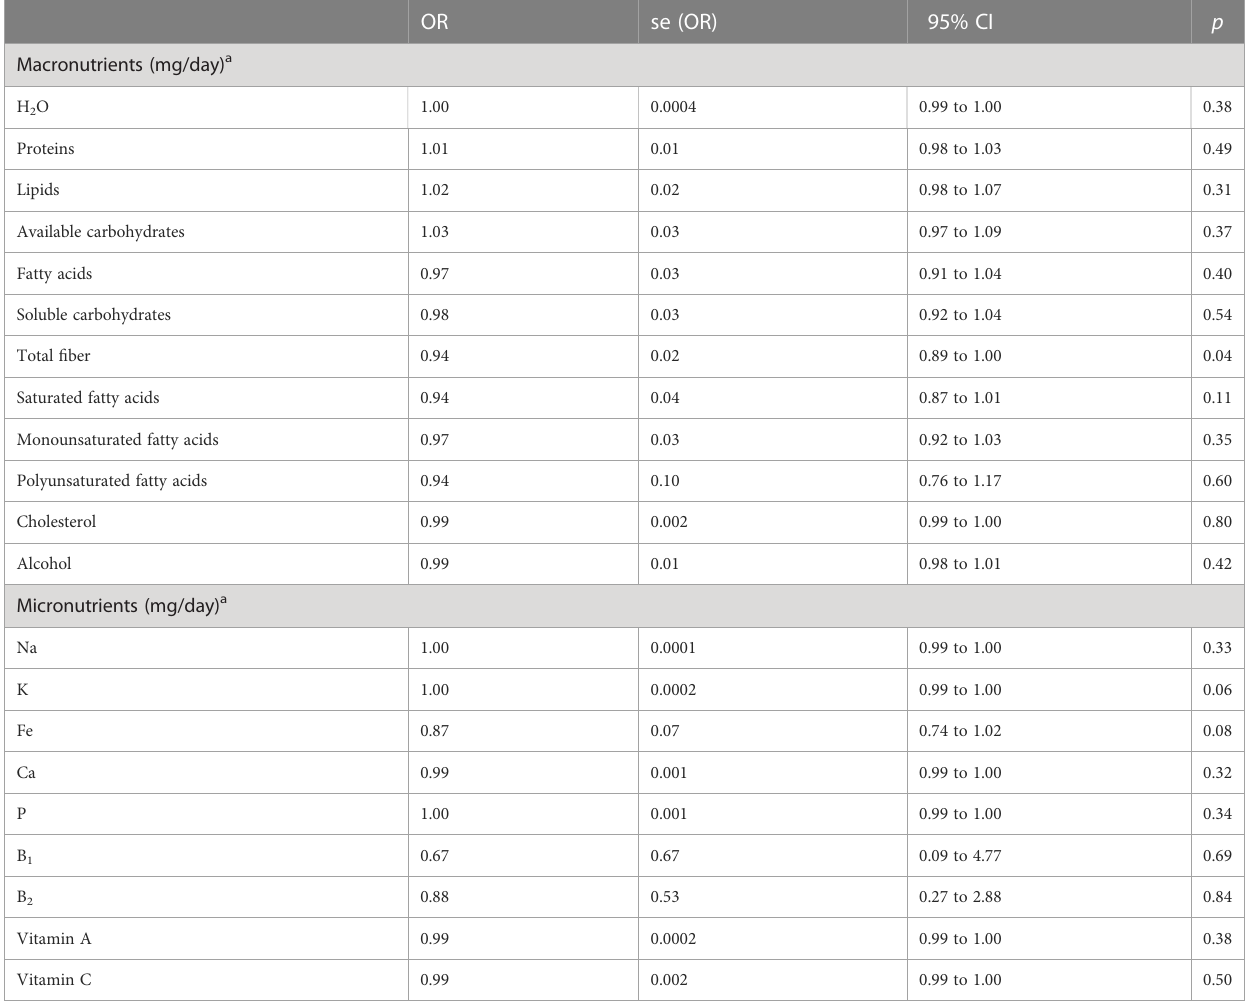
macronutrients we found differences. Lipids and saturated and In Table 2, the association between gastrointestinal cancer and monounsaturated fatty acids were consumed less frequently by macro- and micronutrients is shown together in the model, unaffected patients than by their counterparts, gastrointestinal corrected for age and gender. Only total fi ber as a macronutrient TABLE 2 Logistic regression models on the total cohort of gastrointestinal cancer (no/yes) on macro- and micronutrients, corrected for age and gender, together in the model. OR se (OR) 95% CI